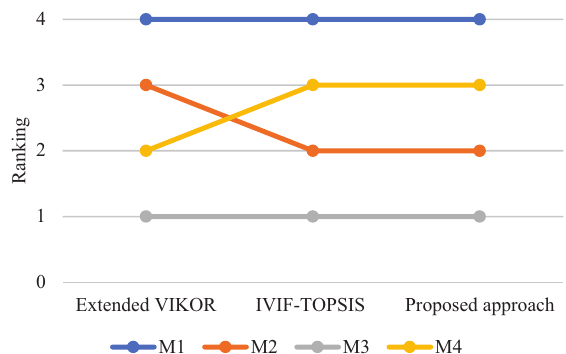
Figure 3. Comparisons of the rankings among three IVIF decision